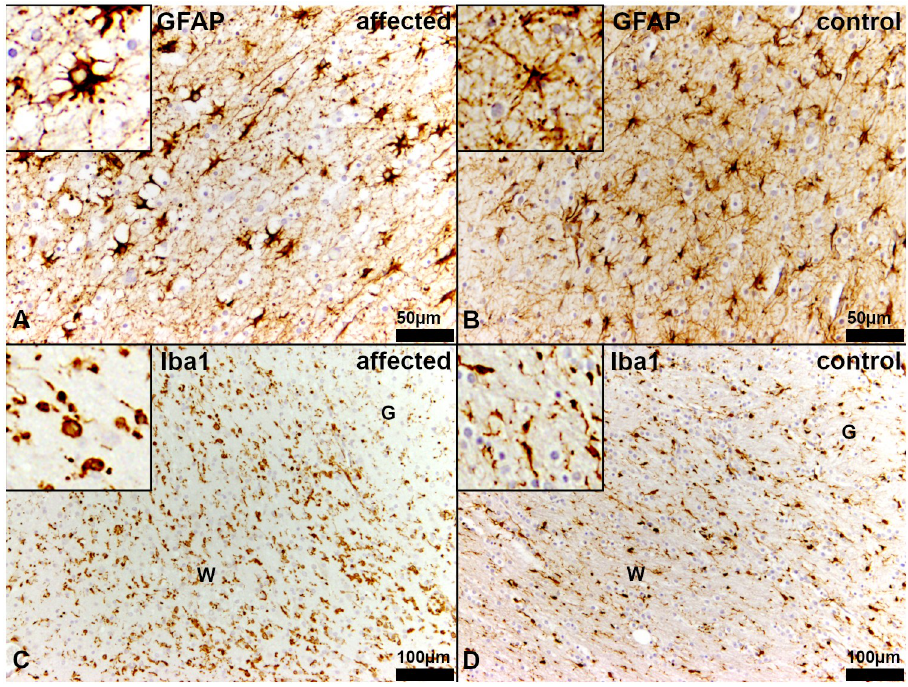
Fig 7. Immunohistochemistry of the white matter in the centrum semiovale of the cerebrum. (A, C) Affected puppy no. 1 and (B, D) age matched healthy control no. 1009. (A) There is a reduced density of astrocytes in the white matter of affected puppies. Most of the astrocytes have a plump morphology developing few short and bulky processes. Inset shows an astrocyte at a higher magnification. (GFAP). (B) In the white matter of age matched control puppies, astrocytes have long, slender branching processes. Inset shows an astrocyte at a higher magnification. (GFAP). (C) Diseased Schnauzer puppies reveal an elevated number of macrophages/microglia in the white matter. Many of these macrophages/microglia have an amoeboid or reactive morphology (arrows). Inset shows amoeboid macrophages/ microglia at higher magnification. (Iba1). (D) In healthy control dogs, there is an equal distribution of microglia in the white (W) and the grey (G) matter. Most of the macrophages/microglia represent the ramified, non-reactive type. Inset shows macrophages/microglia at a higher magnification. (Iba1).